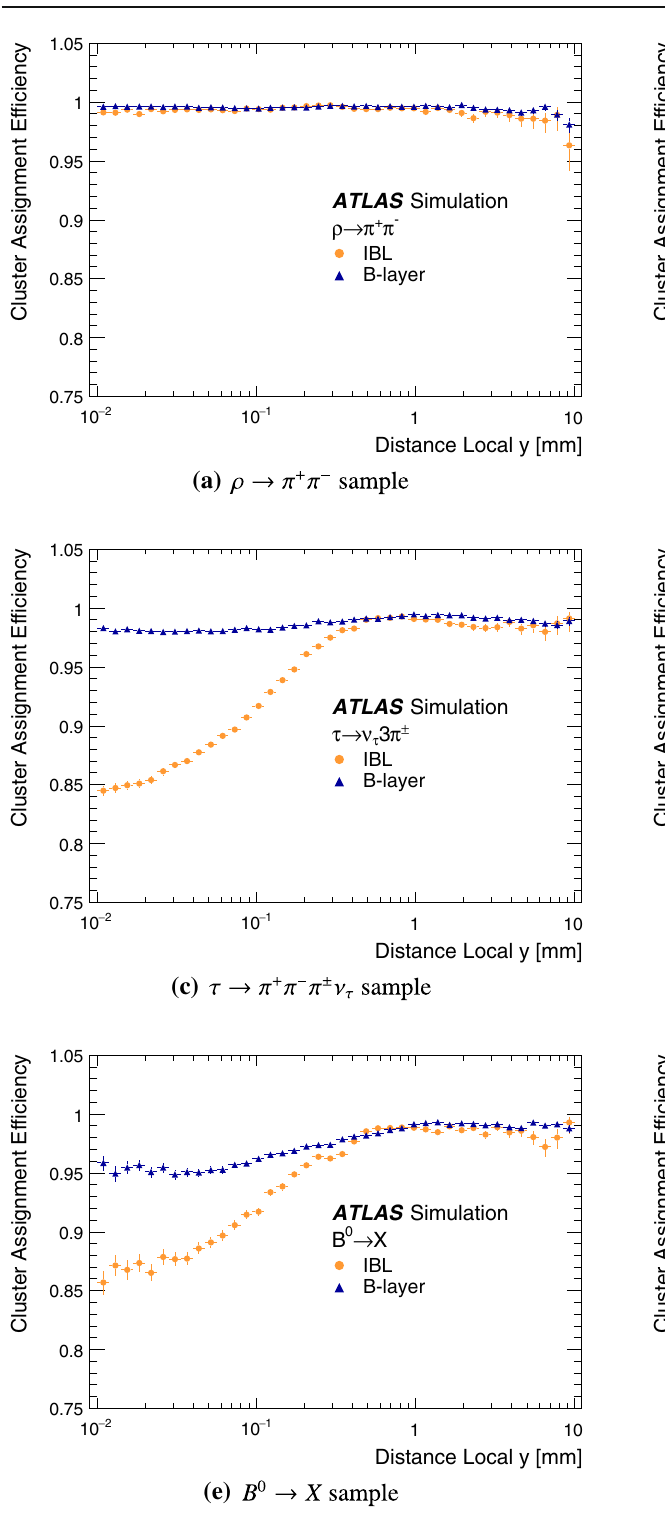
Fig. 10 For the ρ (top), three-prong τ (middle), and B 0 (bottom) samples, the efficiency with which reconstructed clusters are properly assigned to a track is shown for the two innermost pixel layers (IBL and B-layer) as a function of the minimum truth-particle separation in